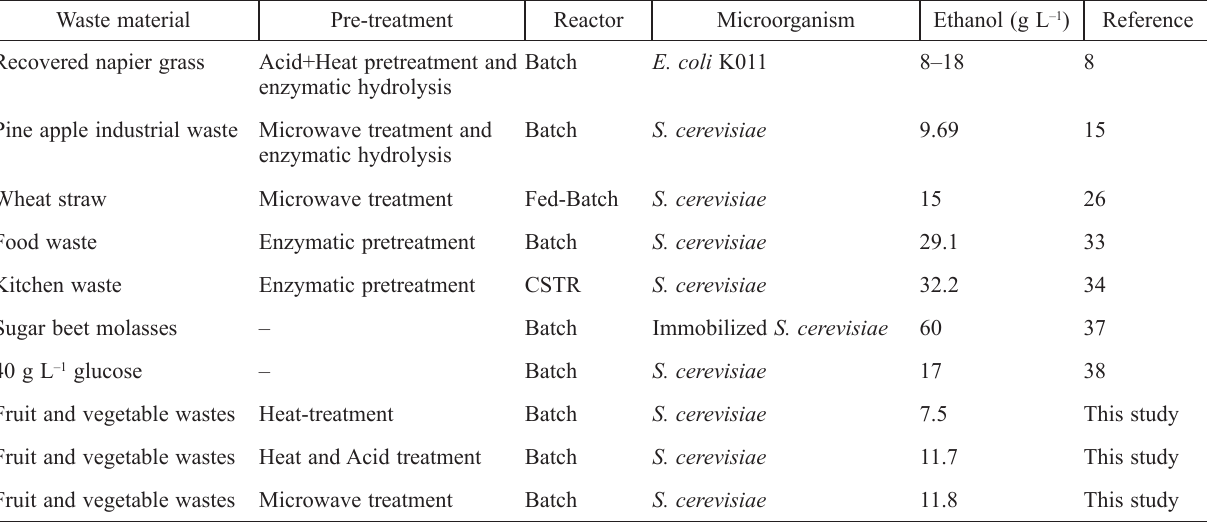
Table 2 – Comparison of the results with literature (yeast fermentation) Waste material Pre-treatment